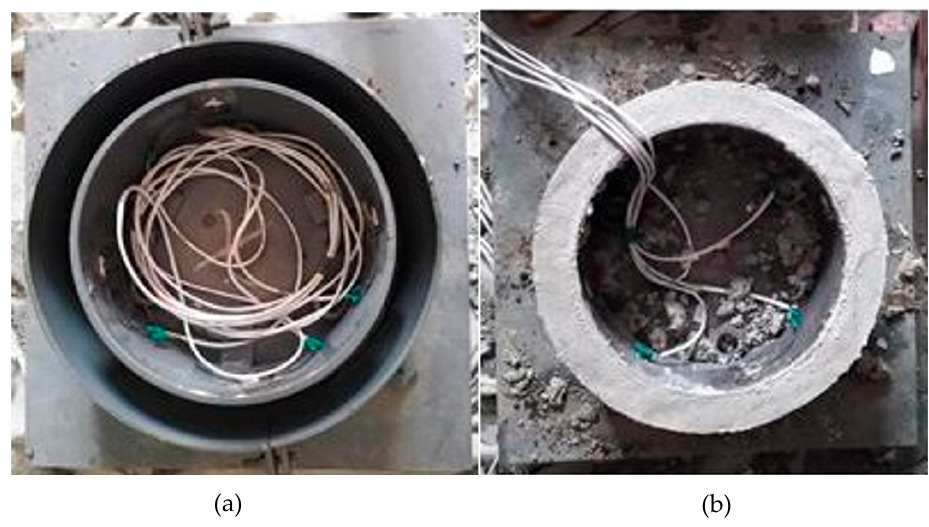
Figure 5. Test specimen of RRST. ( a ) RRST molds; ( b ) RRST